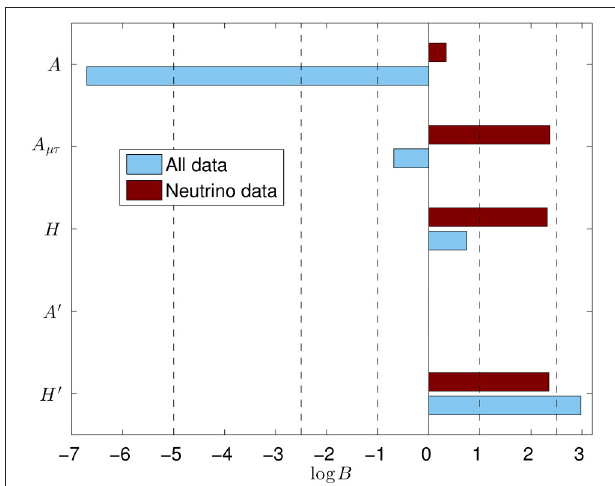
FIGURE 5 | Logarithms of Bayes factors with respect to the model A ′ for the models in Table 4 using only neutrino data (dark-red bars) and all data (light-blue bars). Positive values of log B indicate a weak evidence (log B 1), a = moderate evidence (log B 2.5) and a strong evidence (log B 5) of the = = supposed model against the reference one A ′ . Numerical estimates on ǫ are not reported but values in the range (0.1–0.2) emerged from the analysis as the most appropriate ones.